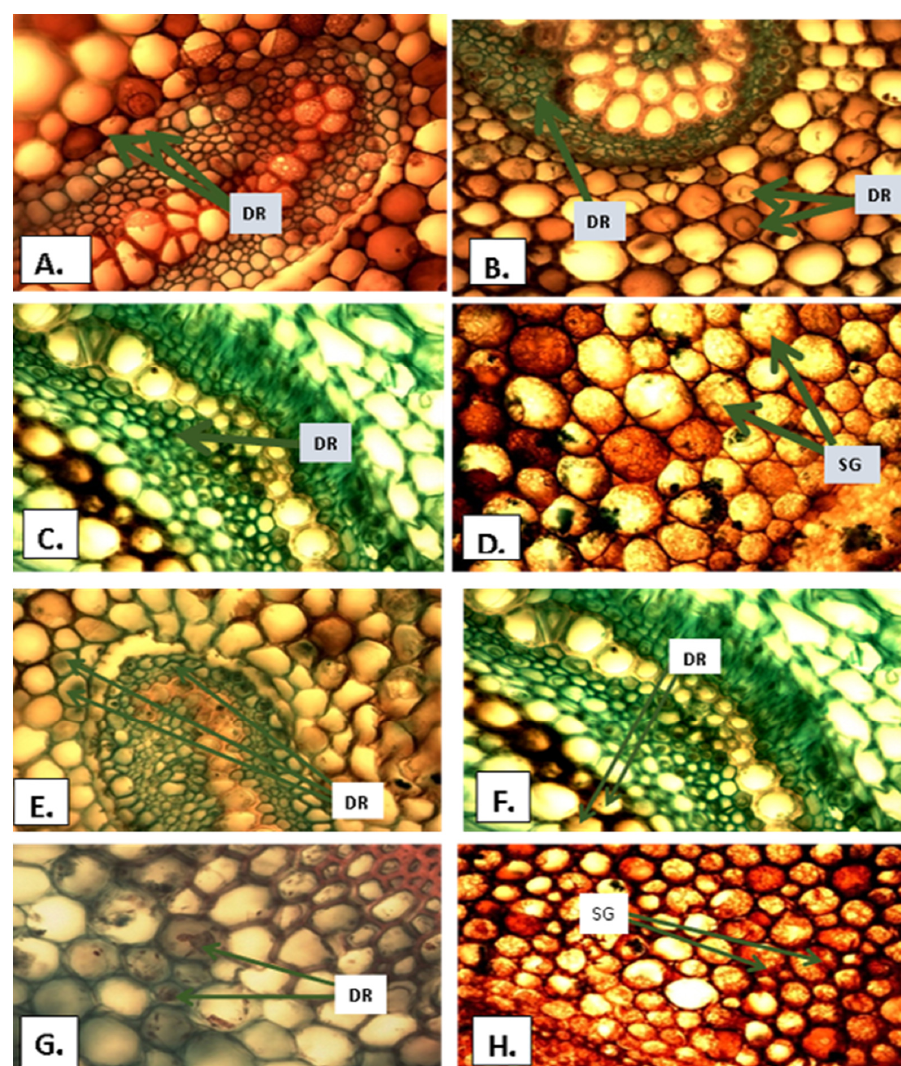
Figure 8. Ergastic substances in median (A-D) and distal (A-H) stipe regions of Pteris species. A: Druses in parenchyma cells of P. acanthoneura, B: Druses in phloem and parenchyma cell P. atrovirens, C: Druses in phloem cells of P. mildbraedii , D: Starch granules in P. togoensis , E. Druses in phloem and parenchyma cells of P. atrovirens, F: Druses in parenchyma of the cortex, P. mildbraedii, G: Druses in phloem cell of P. similis, H: Starch granules in P.